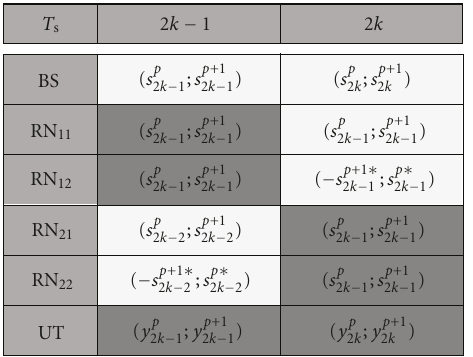
Figure 3: Transmitted (lighter cells) and received (darker cells) signals corresponding to each node of the RA K × 2 × 1 scheme with Precoded